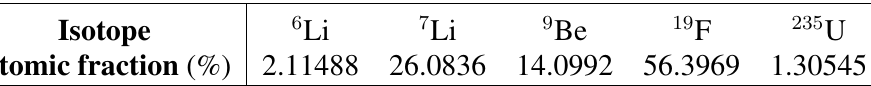
Table 1: Fuel salt